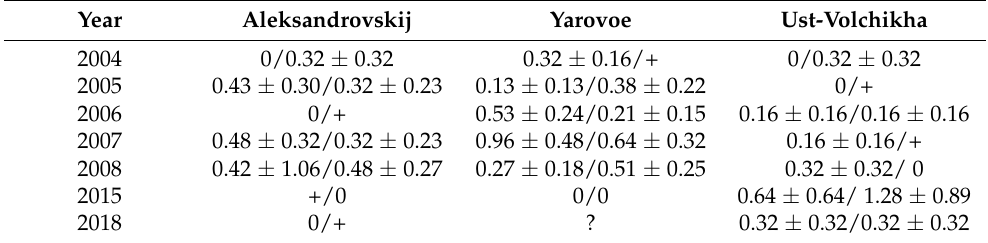
(Table 3). In this case, the Spearman rank-order correlation coefficient is non-significant for each plot and is moderate, but significant for summarized data (r s = 0.446, p = 0.049). Table 3. Dynamics of the average density (ind. per m 2 ± s.e.) of Oedaleus decorus relative to the average density of the Italian locust in the Kulunda steppe.